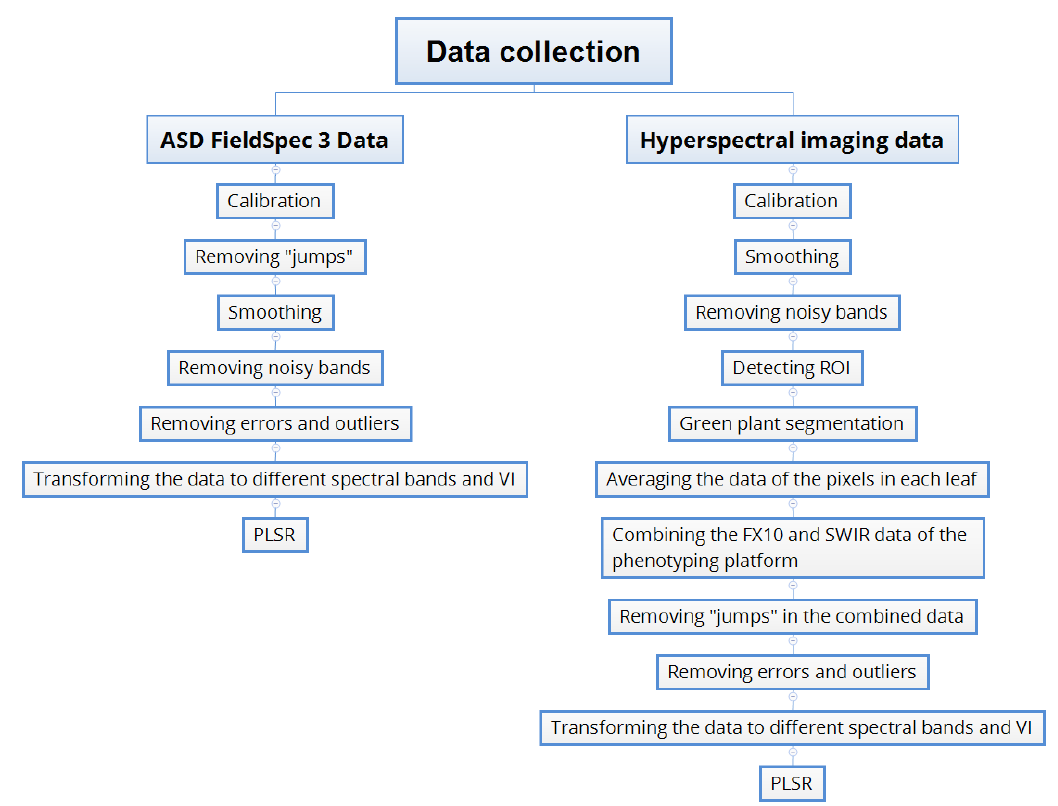
Figure 1. Workflow of hyperspectral data processing.